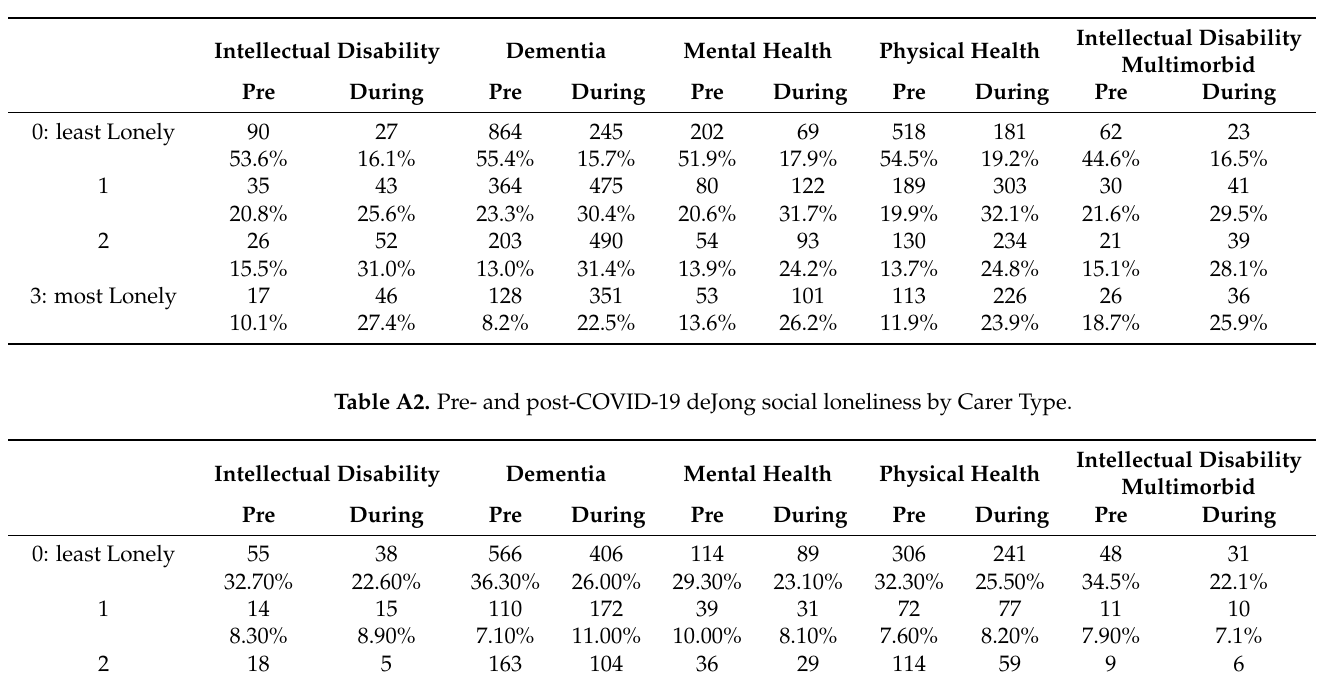
Table A1. Pre- and post-COVID-19 deJong emotional loneliness by Carer Type.